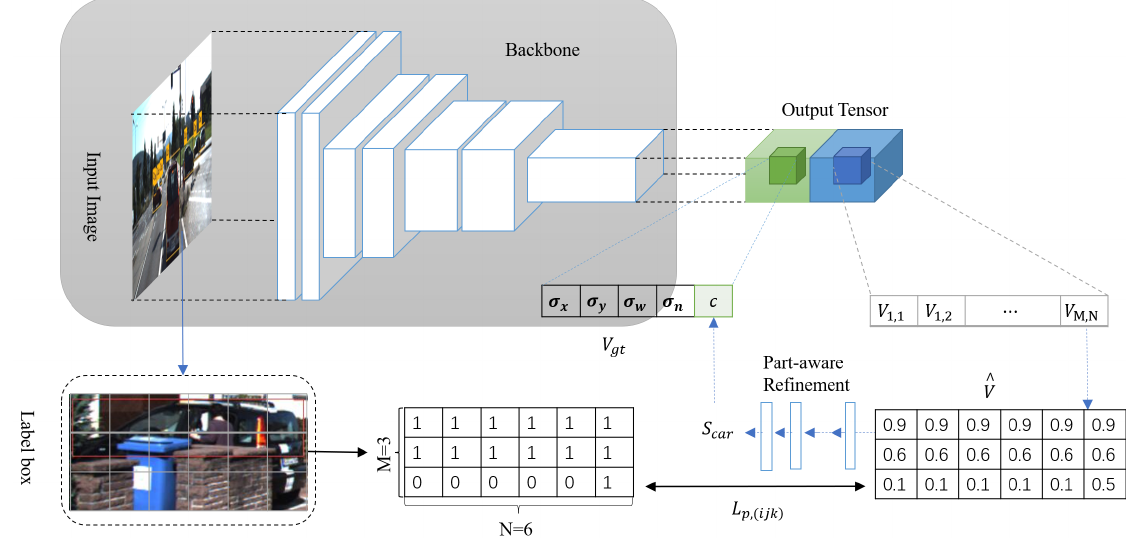
Figure 4. The overview of our occlusion handling method.